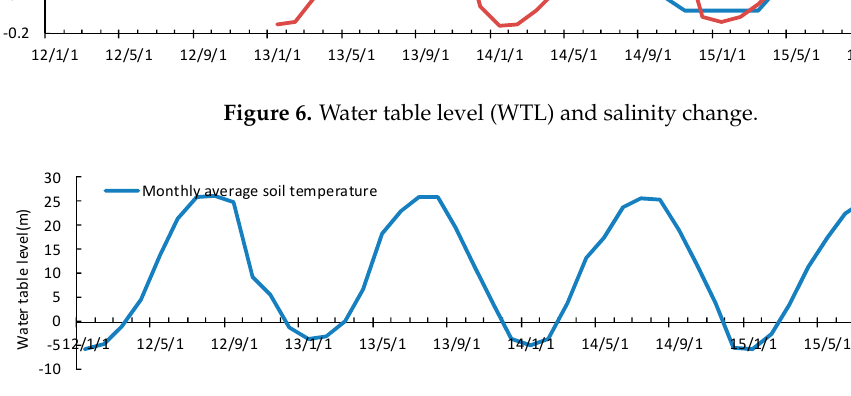
Figure 7. Topsoil temperature change.